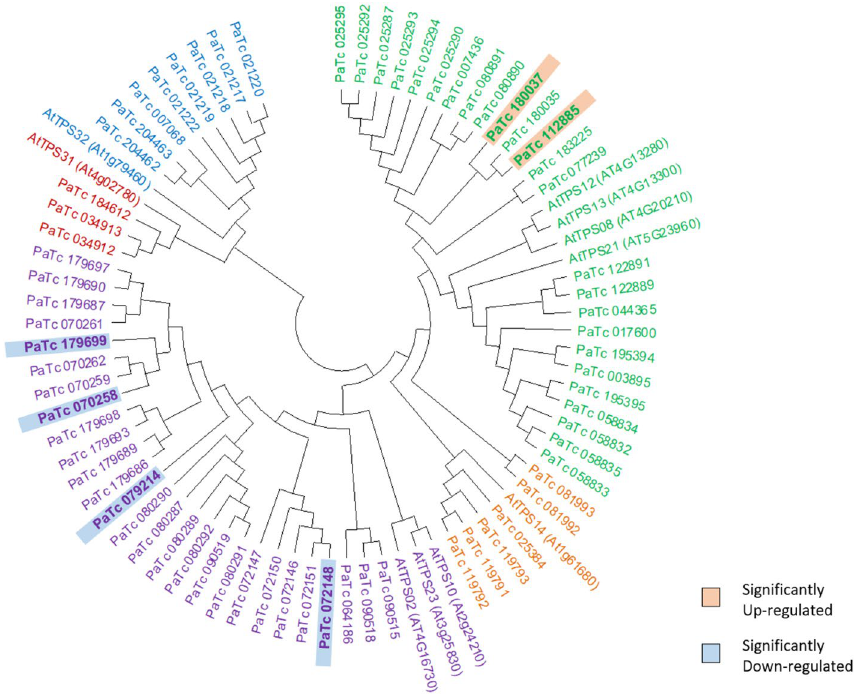
Figure 7. Molecular phylogenetic analysis of terpene synthases TPSs in stem tissue of field-grown guayule. The tree was constructed with MEGA X with maximum Likelihood method. Subfamilies highlighted by color: green (TPS-a), purple (TPS-b), red (TPS-c), blue (TPS-e/f) and orange (TPS-g) respectively. Significantly differentially expressed contigs in